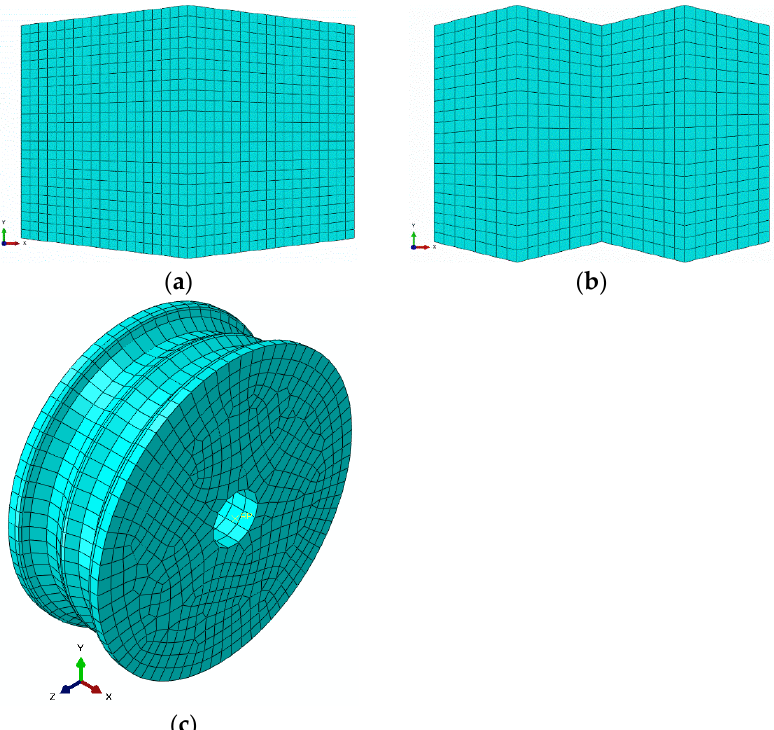
Figure 9. Discretized models of ( a ) single barrel, ( b ) double barrel, ( c ) roller.